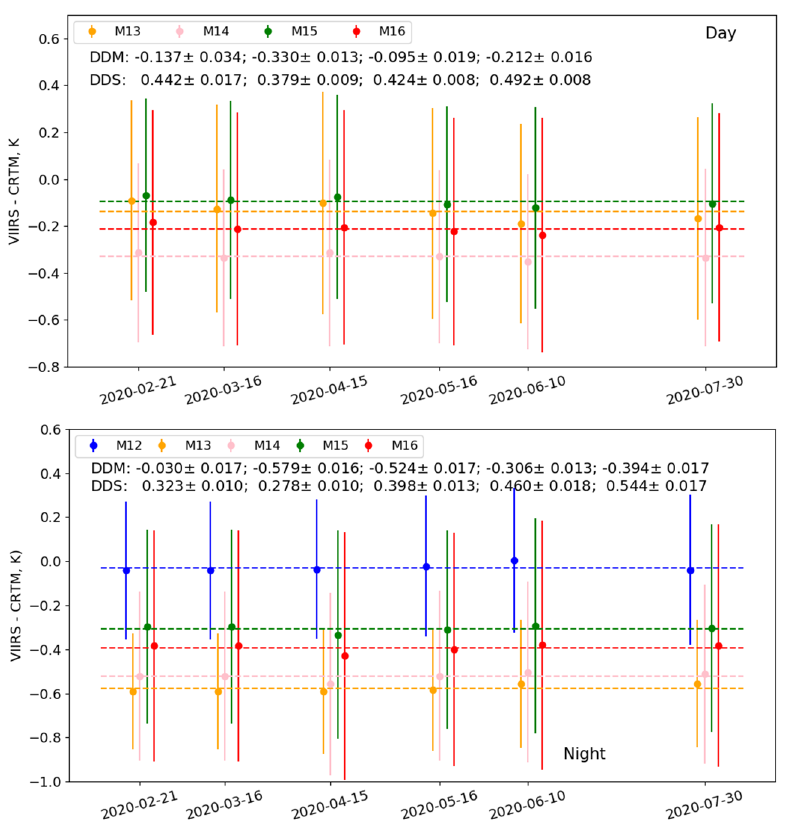
Figure 4. The error bars of the Visible Infrared Imaging Radiometer Suite (VIIRS) O-M biases for six dispersion days from February to July 2020 for day ( upper ) and night ( bottom ). The VIIRS clear-sky pixels were identified by FCDN_CSM. Two-line statistics values present the day-to-day means (DDM) and STDs (DDS) of the O-M means and STDs for each corresponding band ordered from M13 to M16 for daytime and from M12 to M16 for nighttime. The dashed lines represent the DDMs for each band.